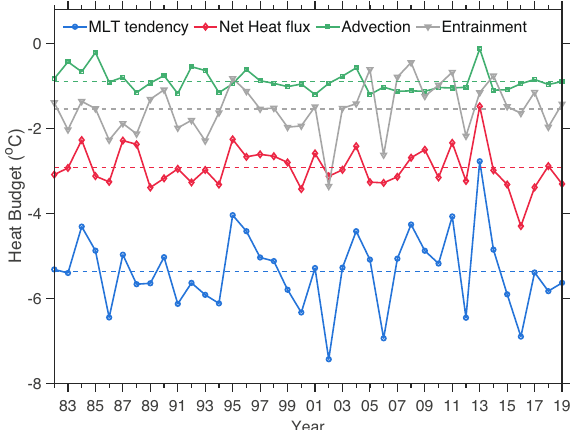
Fig. 3 Mixed layer heat budget during winters of 1982 – 2019. Value of the changes in the mixed layer temperature in the region between 40°N – 50°N, 135°W – 150°W (black box in Fig. 1) from October to January and the mixed layer heat budget terms that caused this temperature change from 1982 to 2019. The budget terms include the heat transferred by net air-sea heat fl ux (red), horizontal advection (green) and vertical entrainment (gray) terms. The values represent the degree of temperature change associated with each